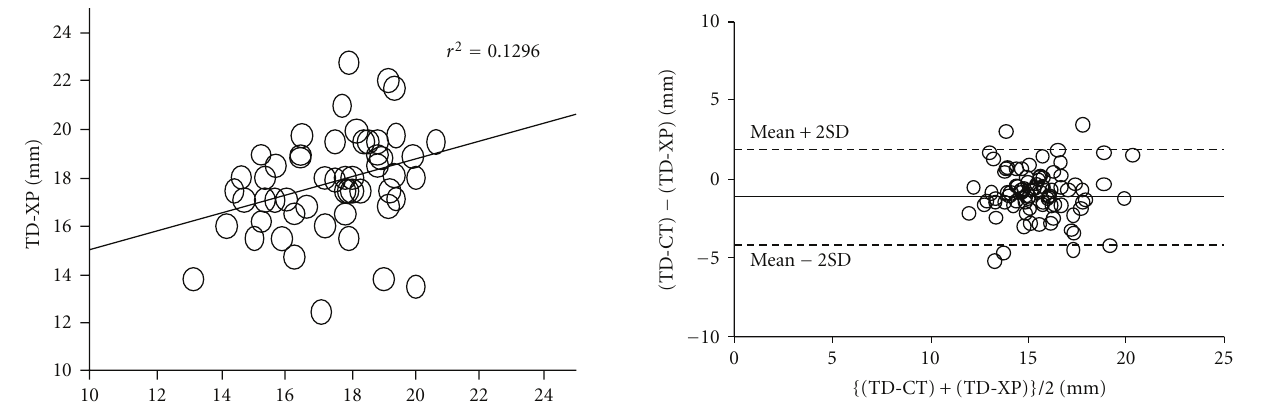
Figure 4: Bland-Altman analysis of TD-CT versus TD-XP in female. The solid line shows bias, and the dotted lines show the limit of agreement.